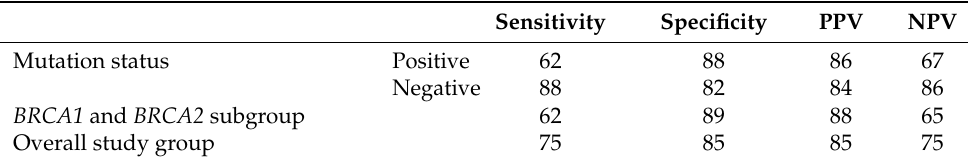
Table 4. Se, SP, PPV and NPV of US in study population.